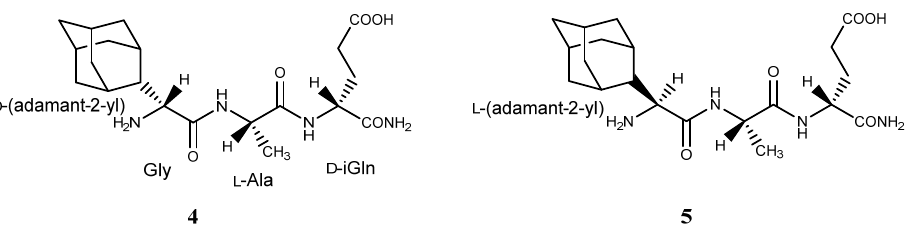
Figure 1. Structures of D ‐ and L ‐ (adamant ‐ 2 ‐ yl) ‐ L ‐ Ala ‐ D ‐ iso Gln (AdTP1 ( 4 ) and AdTP2 ( 5 )).